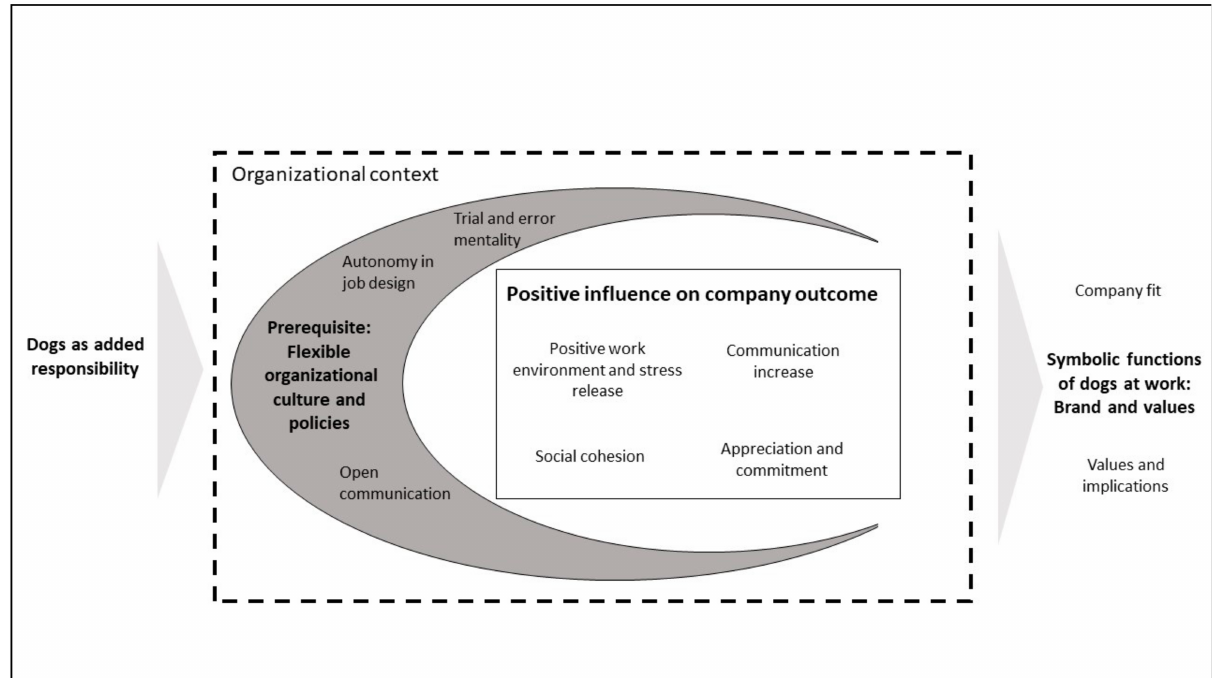
Figure 5. Grounded theory